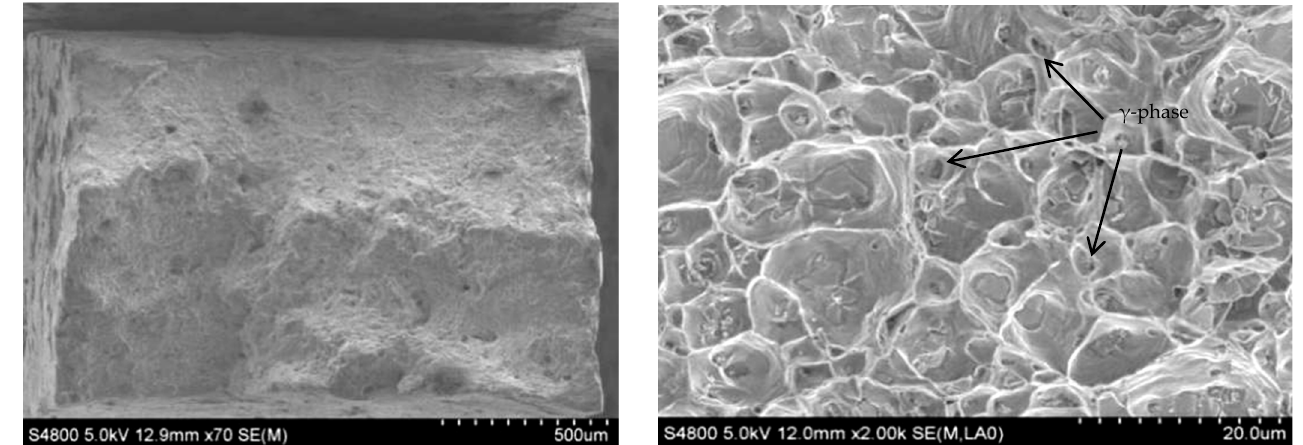
Figure 13. SEM morphology of transverse tensile fracture of Al-Mg alloyed additive.